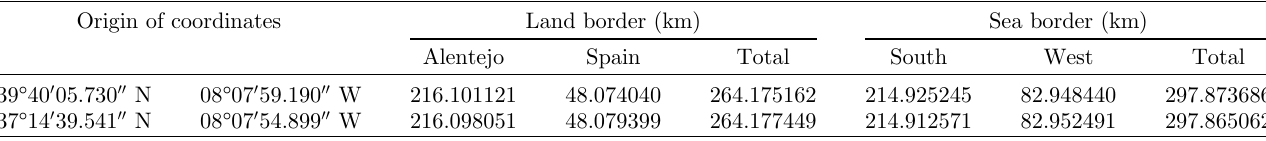
Table 8. Borders of the Algarve by using OAM Algarve ( fi rst line) and NAM Algarve (second line) with LAEA. Origin of coordinates Land border (km) Sea border (km) Alentejo Spain Total South West Total 39 (cid:1) 40 0 05.730 00